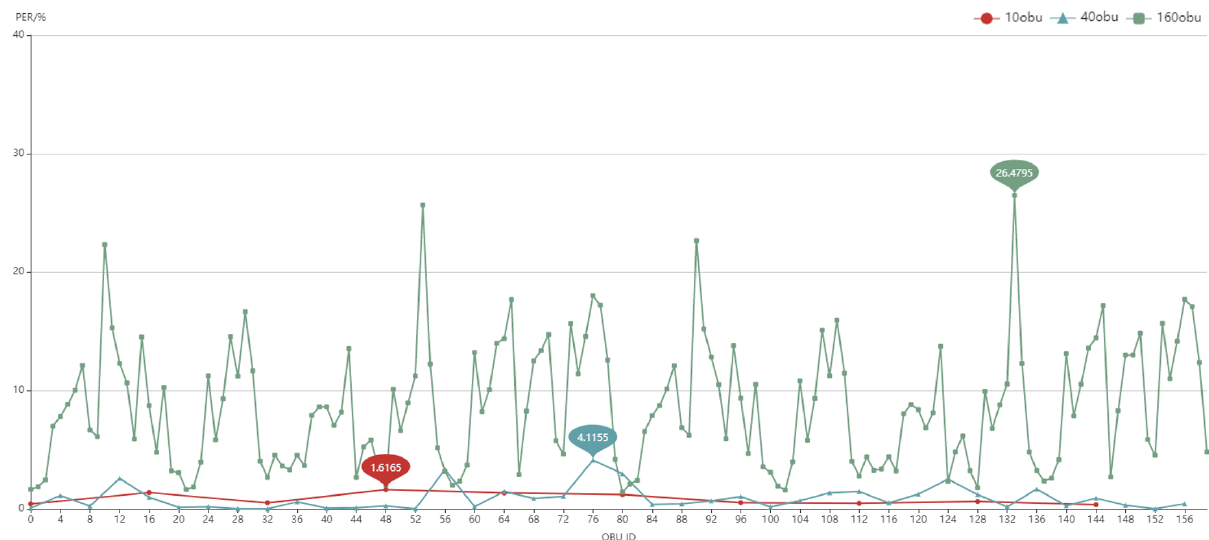
Figure 23. Large-scale test result (PER with 10,40,160 BOBU).